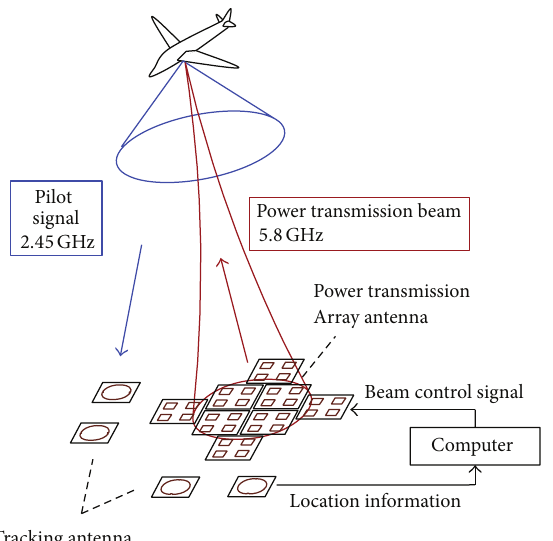
Figure 1: Overview of wireless power transfer to MAV.